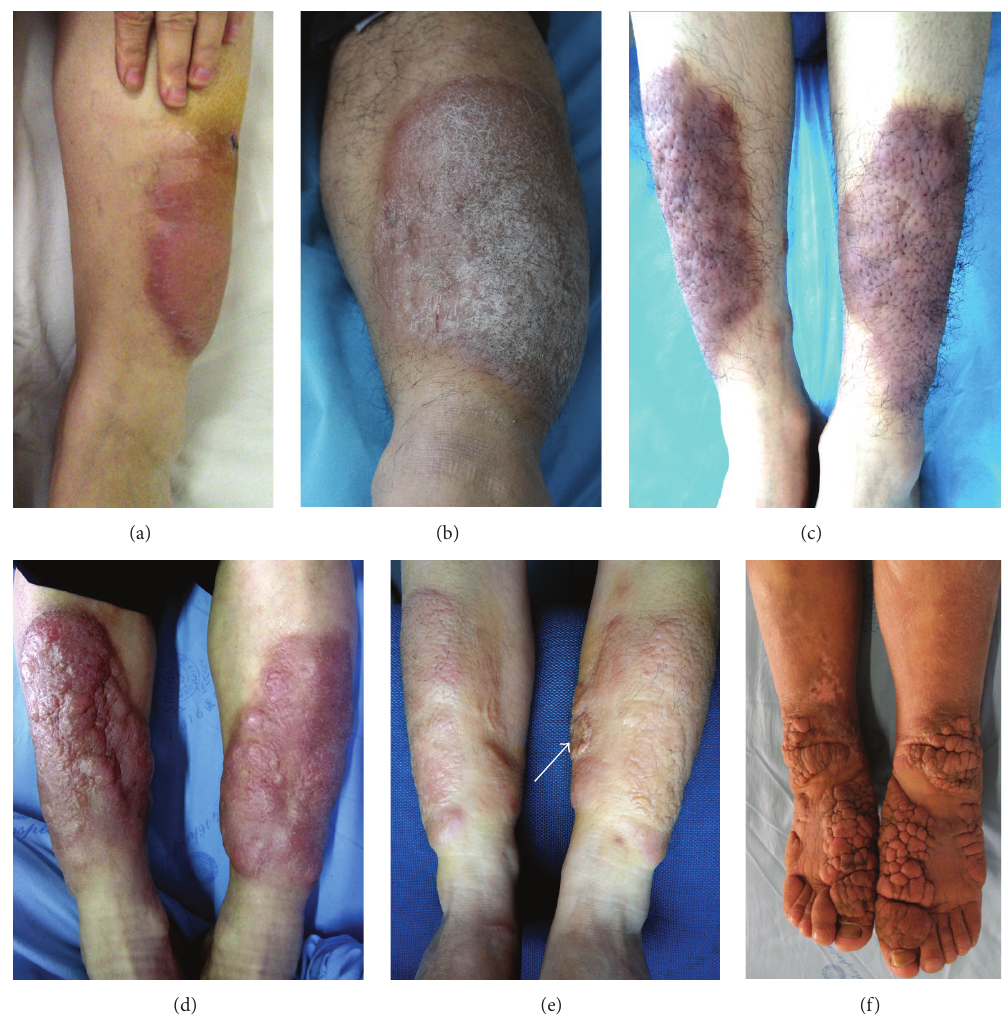
Figure 2: Plaque variant. (a) Well-circumscribed and bright red plaques with smooth appearance at the extensors of lower legs. (b) A single scaly, erythematous plaque at the extensor of left lower leg. (c) Well-circumscribed, pigmented, and orange peel-like plaques with hypertrichosis on the extensors of lower legs. (d) Well-circumscribed, scarlet, and orange peel-like plaques with papule-nodule surface on the extensors of lower legs. (e) Red, orange peel-like plaques on the extensors of lower legs and the arrow indicated a hypertrophic scar. (f) Multiple, skin-color, and fungating plaques on the back of toes and feet and at the flexor aspect of ankles.